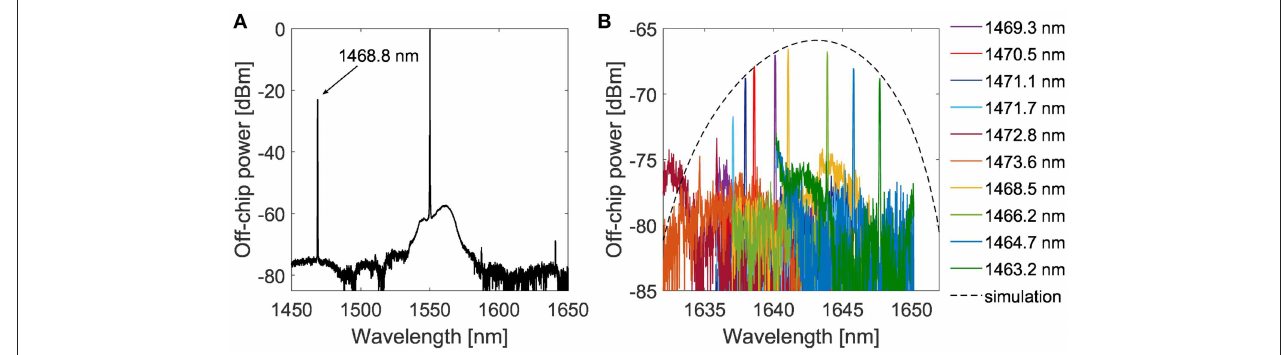
FIGURE 10 | Stimulated inter-modal FWM with 1221TE phase-matching combination in a 4 µ m wide waveguide. The pump is CW at 1,550nm. (A) Stimulated inter-modal FWM spectrum. The gray boxes highlight the spurious peaks. The seed is at 1468.8nm. (B) Signal spectra as a function of the seed wavelength (in legend). The black dashed line refers to the simulated FWM efficiency.